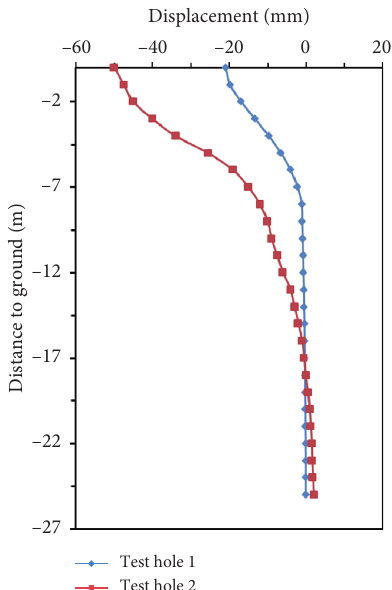
Figure 6: Displacement of soil body corresponding to an em- bankment filling height increase from 4 m to